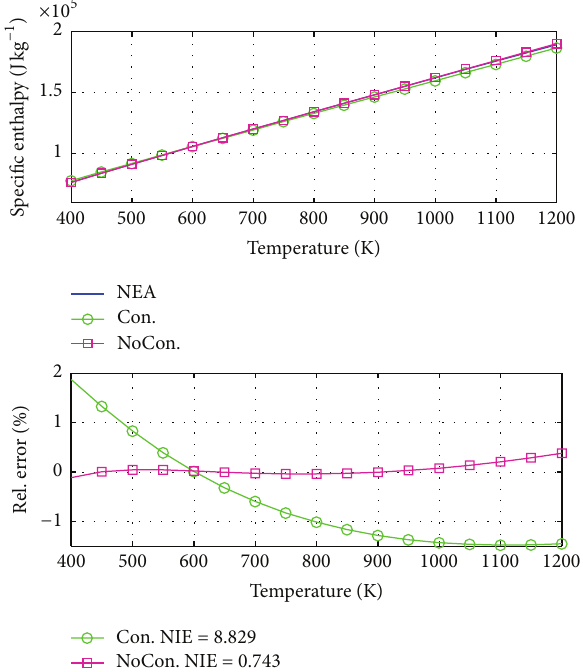
Figure 14: LBE specific enthalpy, NEA data versus constrained and nonconstrained optimization results.